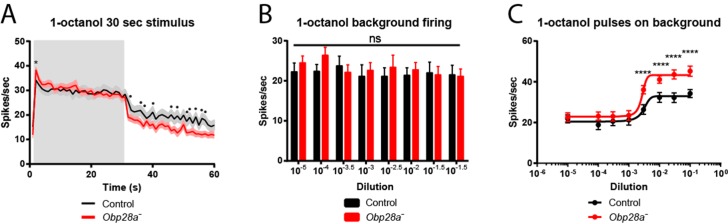
Altered responses of Obp28a in prolonged stimulus paradigms.(A) PSTH of ab8 responses to 30s presentations of a 10−1.5 dilution of 1-octanol in control (black) and Obp28a- (red). Gray box indicates stimulus presentation. Shaded areas display SEM. The graph displays a 60 s time window in 1 s bins. • p<0.05, n = 18; we note that for five of the bins, p<0.0001. We also asked whether the increased initial response of the mutant, indicated by *, was significant when the responses were examined in 50 ms bins, as in Figure 5, and found that p<0.05. (B) Background firing rates in response to prolonged (>5 min) stimulation of a 10−2.5 dilution of 1-octanol. Each bar represents data prior to the administration of a short pulse of the indicated dose. ns = not significant, n = 16. C Dose-response curves of ab8 neurons to increasing doses of 1-octanol superimposed on the 10−2.5 1-octanol background. Spike rates are calculated from the number of spikes during the stimulus period, without subtracting the background firing rate. **** p<0.0001, n = 16.